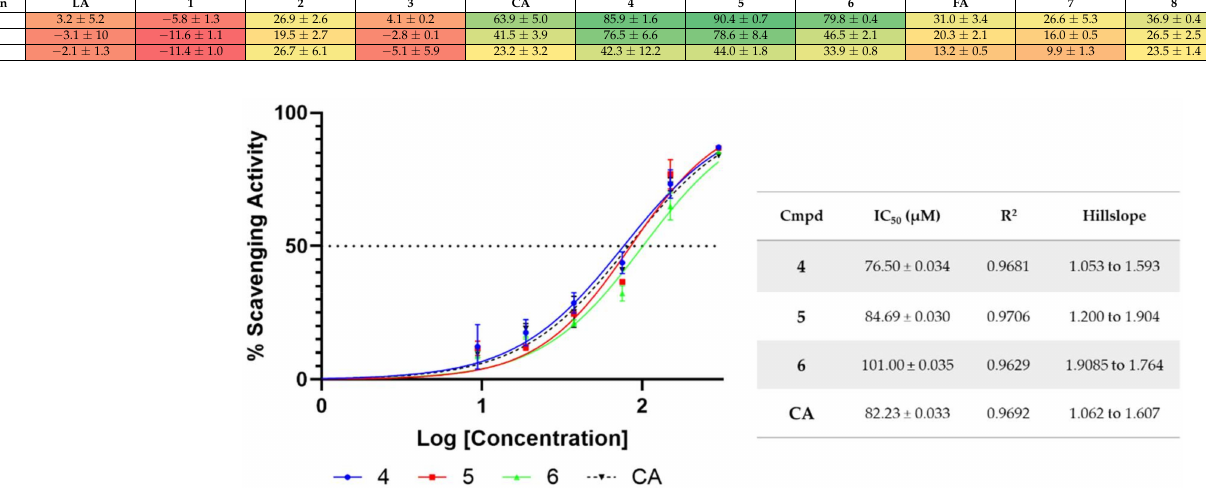
Figure 3. Dose–response curve of DPPH radical-scavenging activity for compounds 4 – 6 and caffeic acid. Compounds were incubated for 45 min at descending concentrations (300–0 µ M) with 500 µ M DPPH solution. IC 50 values ± SD are indicated in the table. Data are from